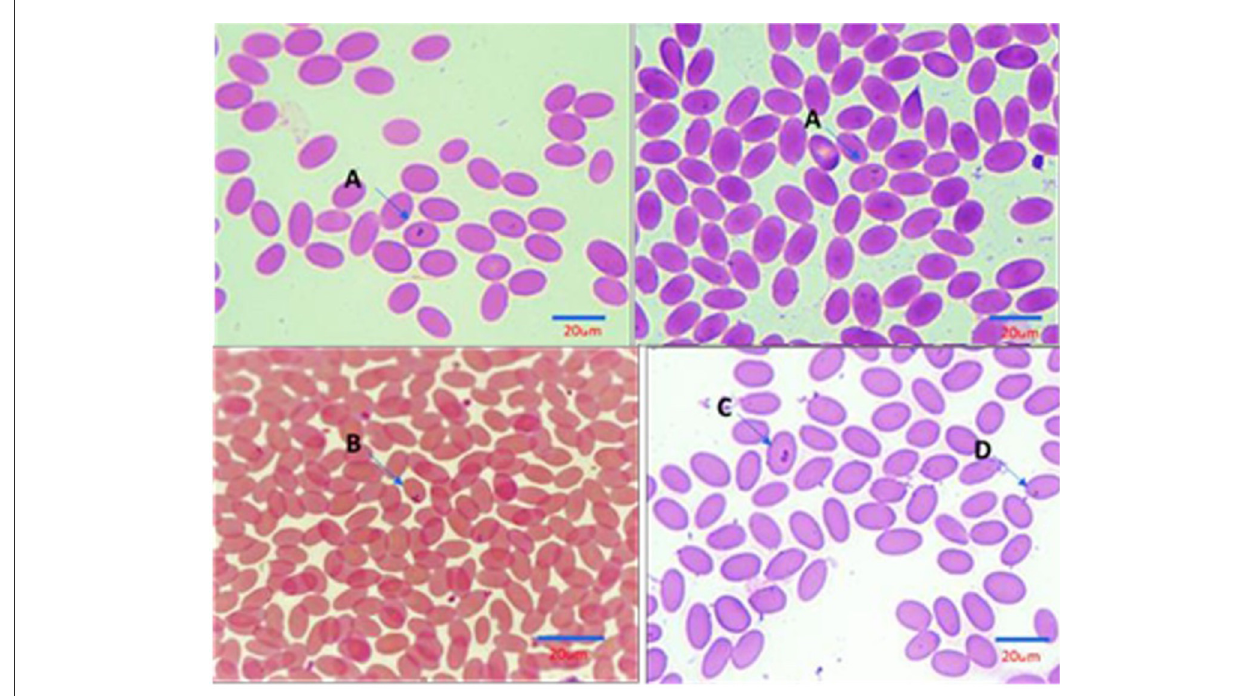
FIGURE2 Illustration of Intra erythrocytic stages of Piroplasma -infecting camel under the light microscope (Diff Quick, 1,000 × ). (A) Double small piroplasmid; (B) Maltese cross formation; (C) Double large piroplasmid; (D) Single small piroplasm (1.5–2 µ m). Size bars represent 20mm.